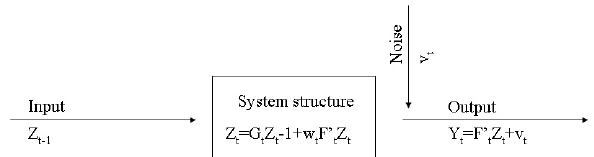
Fig. 2. Stochastic representation of input-output transformation